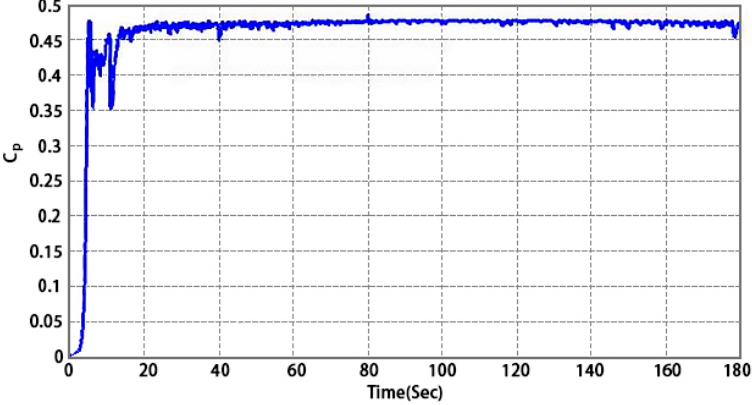
Figure 9. Power coe ffi Figure 9. power coefficient.